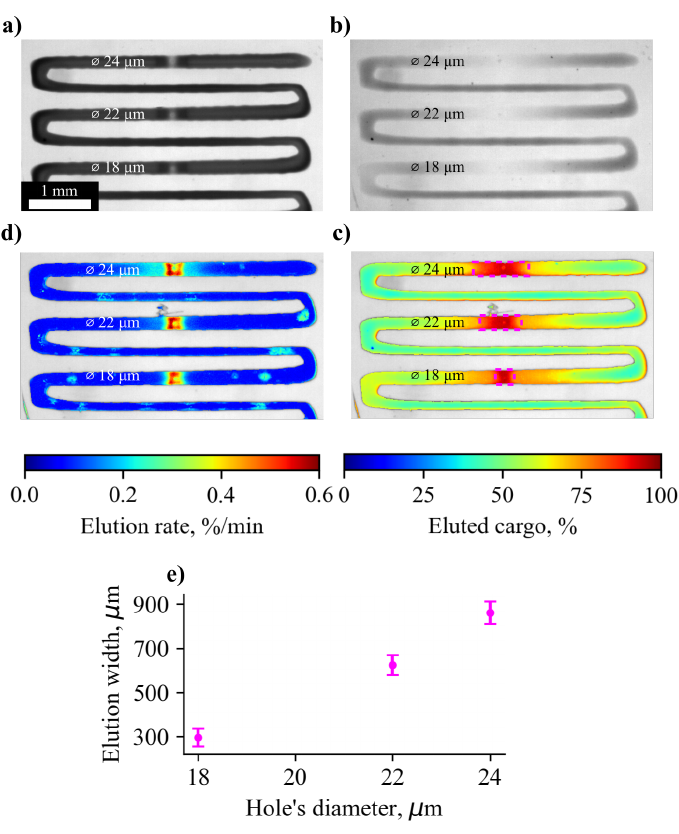
Figure 3. ( a ) Initial state of an MB loaded film placed in a flow cell. ( b ) Visual appearance of an MB loaded film after 24 h in a high flow environment. ( c ) Pseudo-colored map of the amount of eluted cargo from an MB-loaded film with microperforations of different diameters after 24 h in a high flow environment. ( d ) Pseudo-colored map of maximal observable elution rate for the holes with different diameters and their neighborhood. ( e ) The dependence between the hole’s diameter and the width of the elution zone with high amount of released substance